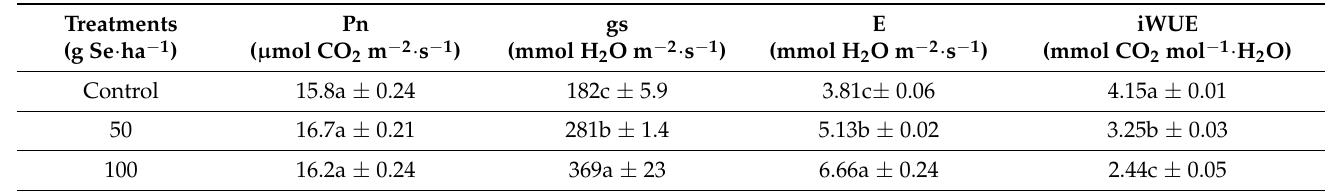
Table 1. Leaf gas exchange parameters – net photosynthesis (Pn), stomatal conductance to water vapor (gs), transpiration (E) rates and instantaneous water use efficiency (iWUE = Pn/E) in leaves of Oryza sativa , variety Ariete. Average values ± standard errors ( n = 4–6). Letters a, b and c indicate significant differences between treatments ( p ≤ 0.05).